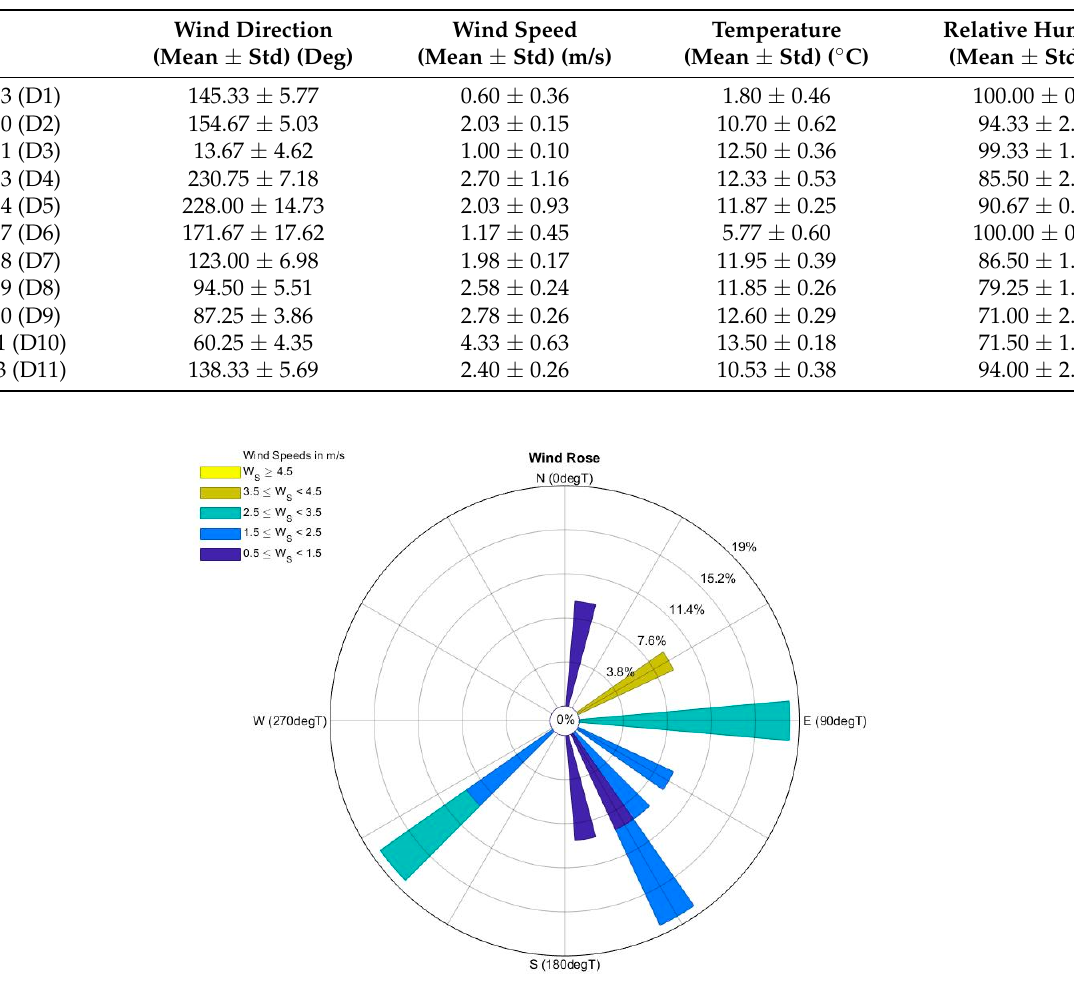
Table 2. The meteorological parameters retrieved from NIWA (mean and standard deviation were obtained based on three collections of 10-min data).